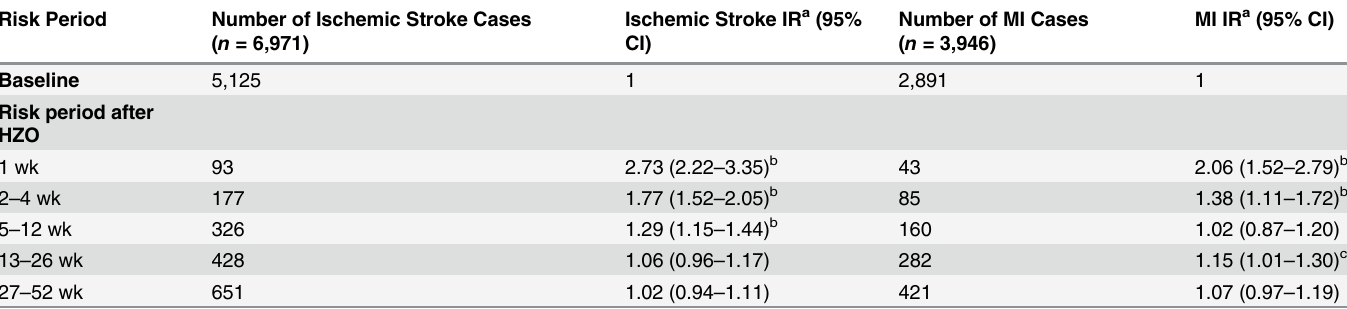
Table 3. Age-adjusted incidence ratios for ischemic stroke and myocardial infarction in risk periods after herpes zoster ophthalmicus. Risk